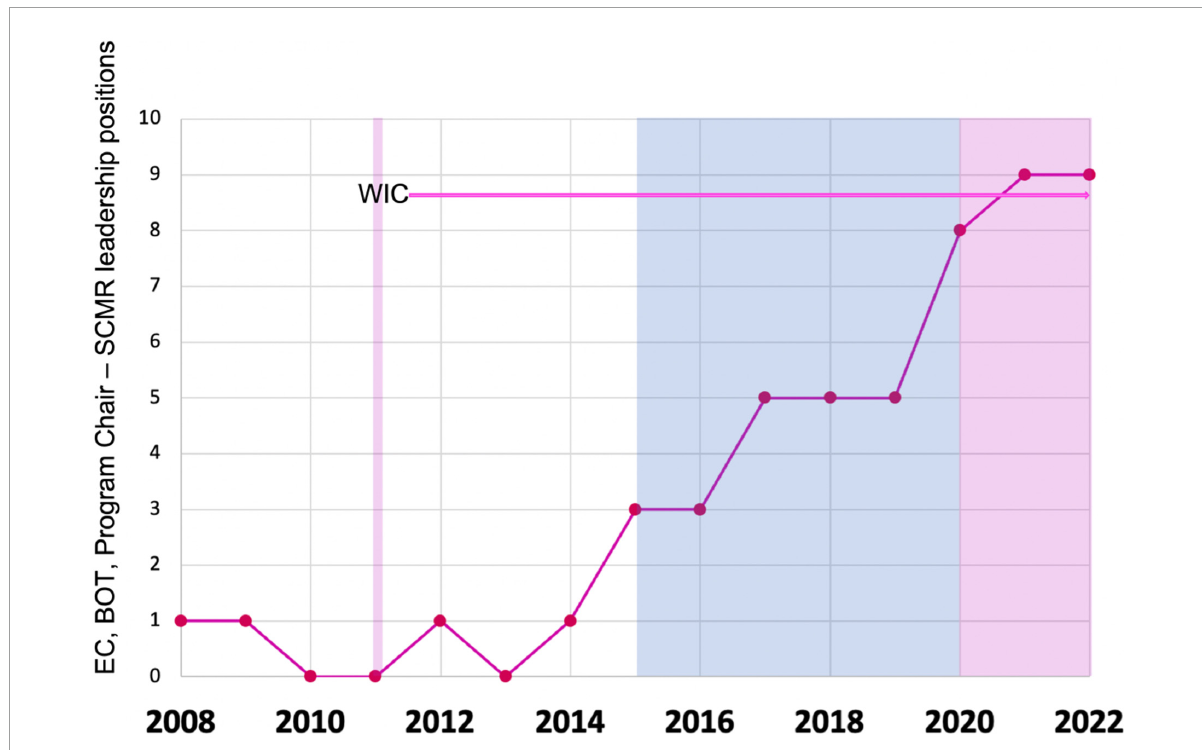
FIGURE7 Women’s representation in SCMR leadership. The blue background represents the first CEO (male) and the pink the second and current CEO (female) of SCMR. The thick pink line marks the Women in CMR (Special group of SCMR) establishment as a Task Force by Dara L. Kraitchman, Ph.D., and supported by the E.C. leadership by Victor A. Ferrari, MD. EC, Executive Committee; BOT, Board of Trustees; WIC, women in CMR (Special group of